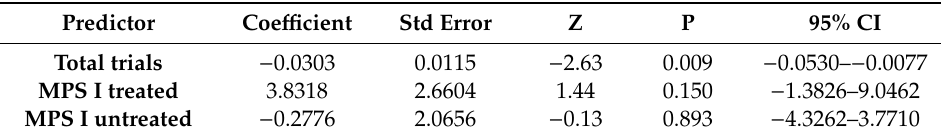
Table 18. Preliminary training for scent discrimination firth logistic regression model. Analysis of MPS I a ff ected groups compared to normal group for choice (correct versus incorrect) at each session x trial for preliminary